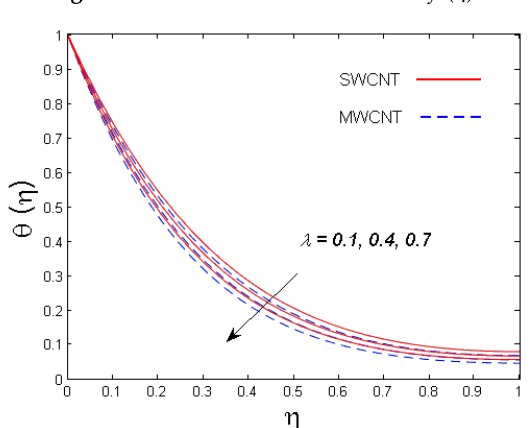
Figure 4. The illustration t of λ versus f ’(η).